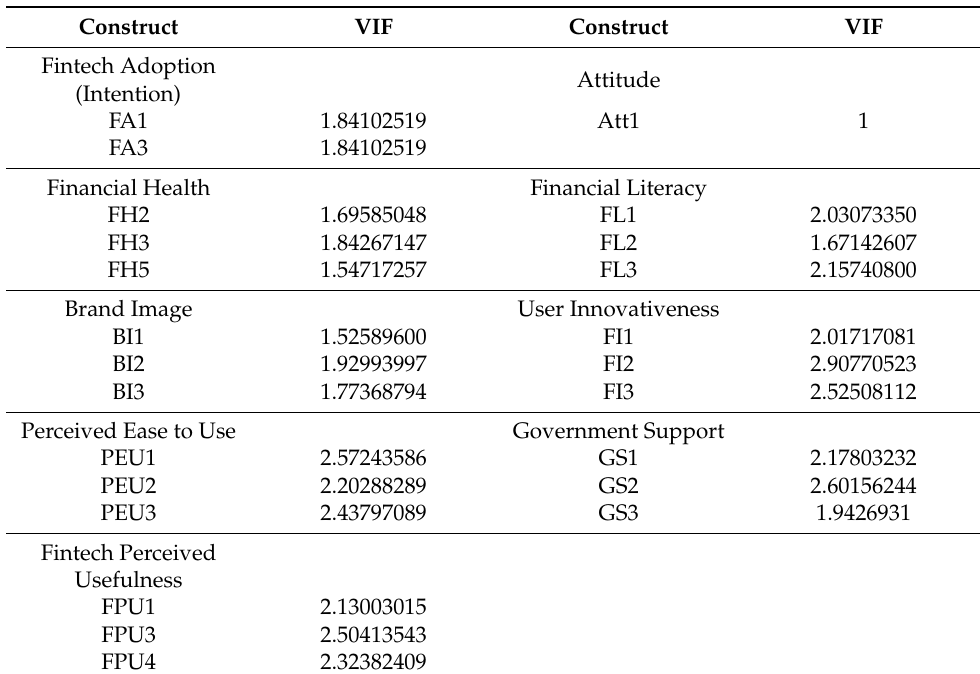
Table 6. Variance inflation (VIF)